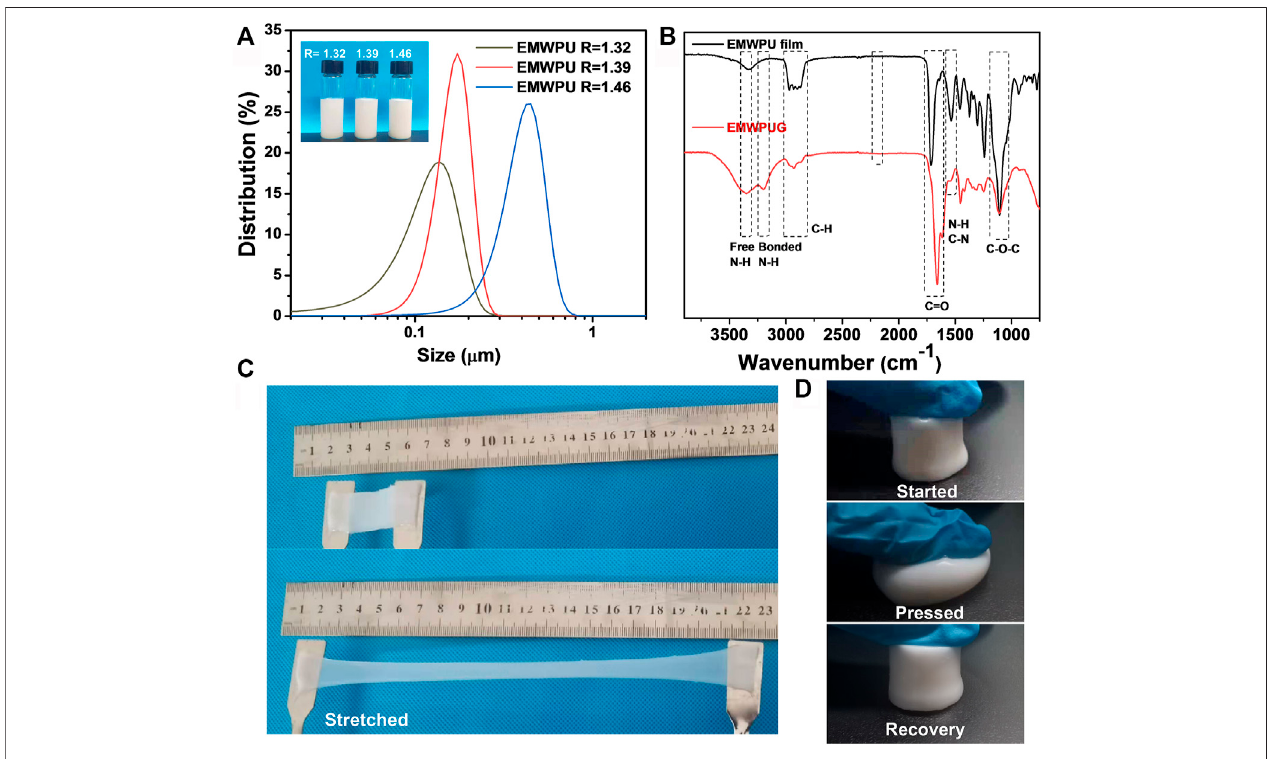
FIGURE2|(A) ParticlesizedistributionofEMWPUemulsionandsamplesEMWPUemulsionswithdifferent R values(insert). (B) FTIRspectrumofEMWPU fi lmand EMWPUG after freeze-drying. Photos of the (C) stretchable EMWPU hydrogels and the (D) recovery property of EMWPUG after pressed by an index fi nger.